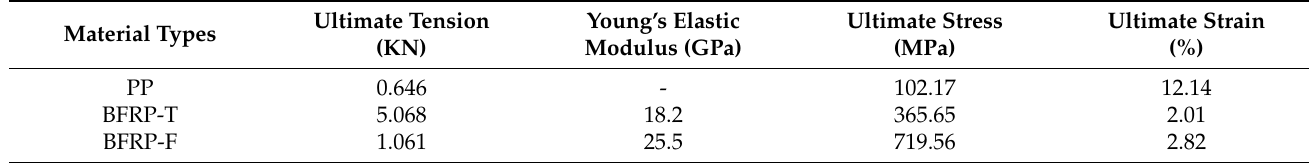
Table 5. Key mechanical property parameters of reinforced